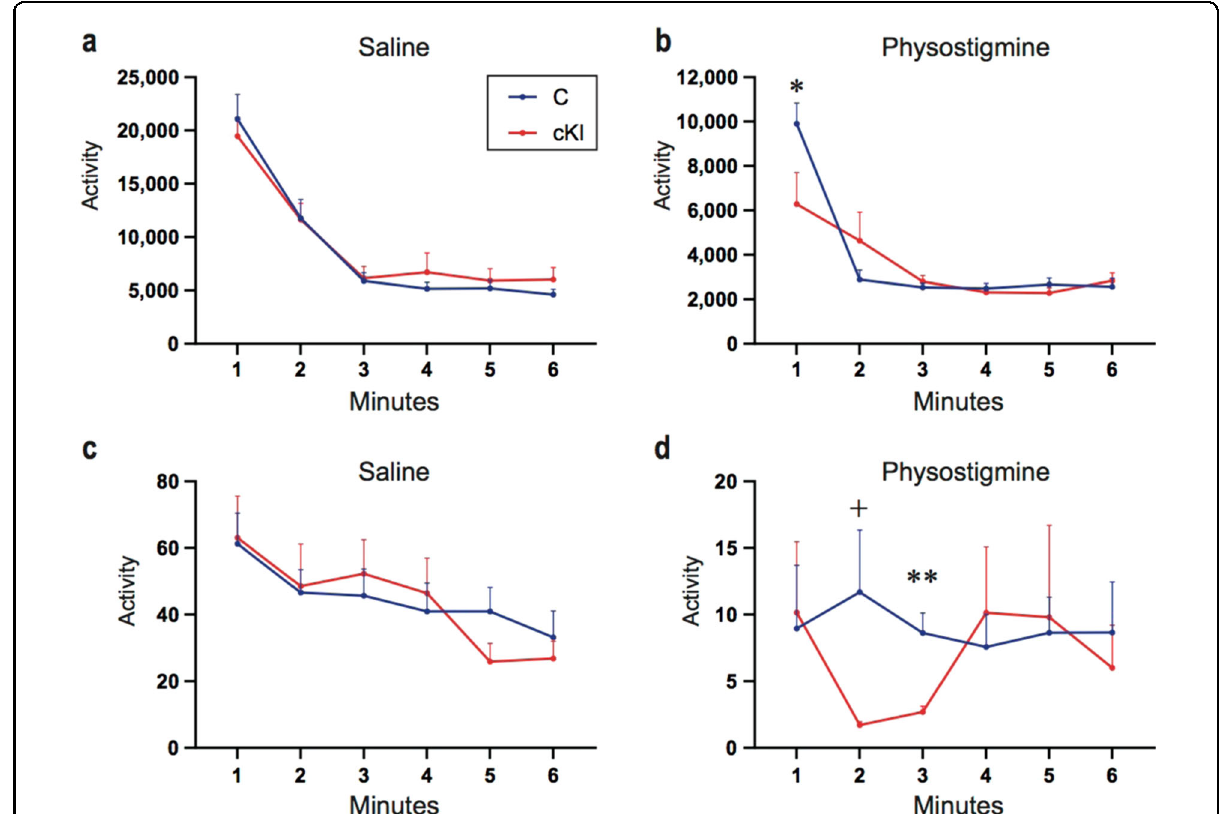
Fig. 4 Depression like behavior under physostigmine administration in the Ntrk1 cKI mice. a Tail suspension test at the drug free state (saline). Control, N = 13; cKI, N = 13. b Tail suspension test after the physostigmine injection. Control, N = 13; cKI, N = 8. c Drug free state (saline) in an independent test. Control, N = 8; cKI, N = 8. d Increased depression-like behavior of the cKI mice with physostigmine was reproducibly observed in an independent test. Control, N = 8; cKI, N = 8. * p < 0.05, + p = 0.05, ** p < 0.005 ( t -test, two-tailed); Error bars, mean ±